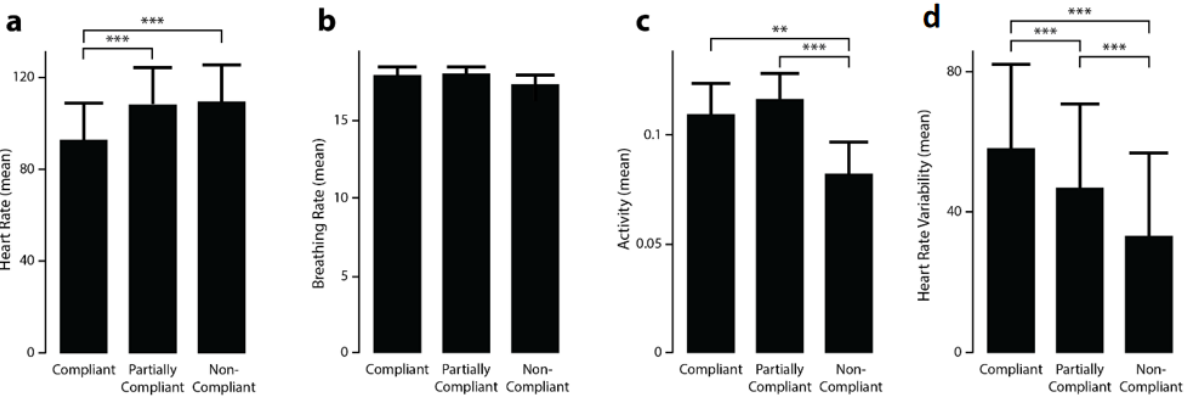
Figure 8. Estimate of ( a ) heart rate, ( b ) breathing rate, ( c ) activity, ( d ) heart rate variability for all 3 conditions: compliant, partially compliant, and non-compliant; ** p < 0.01, *** p < 0.001.